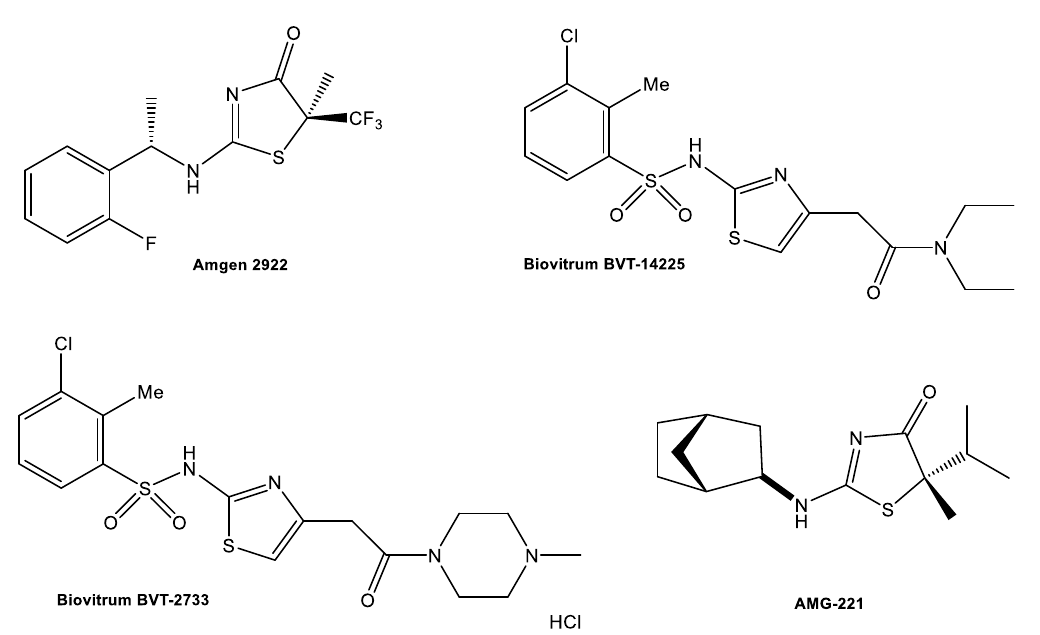
Figure 1. 11 β -hydroxysteroid dehydrogenase type 1 inhibitors. Figure 1. 11β -hydroxysteroid dehydrogenase type 1 inhibitors. Figure 1. 11β -hydroxysteroid dehydrogenase type 1 inhibitors.